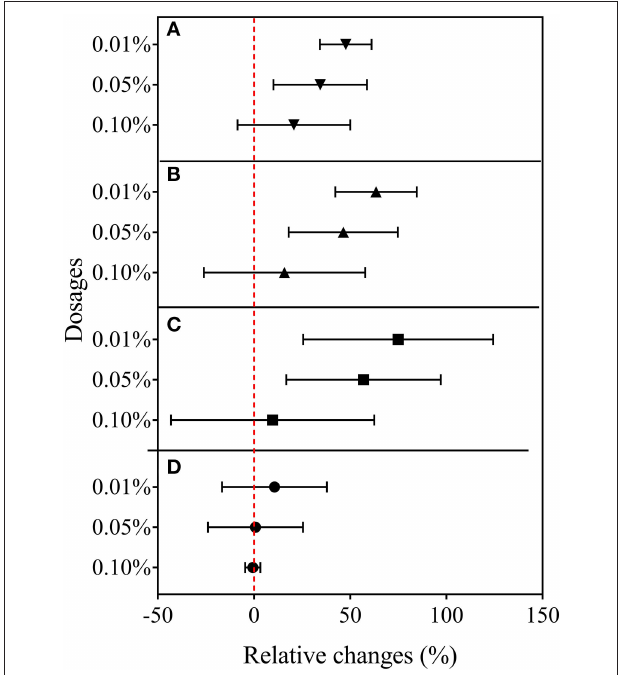
FIGURE 5 | Relative changes in root morphological traits in Experiment 2a ( n = 4). (A) Root length, (B) surface area, (C) volume, and (D)